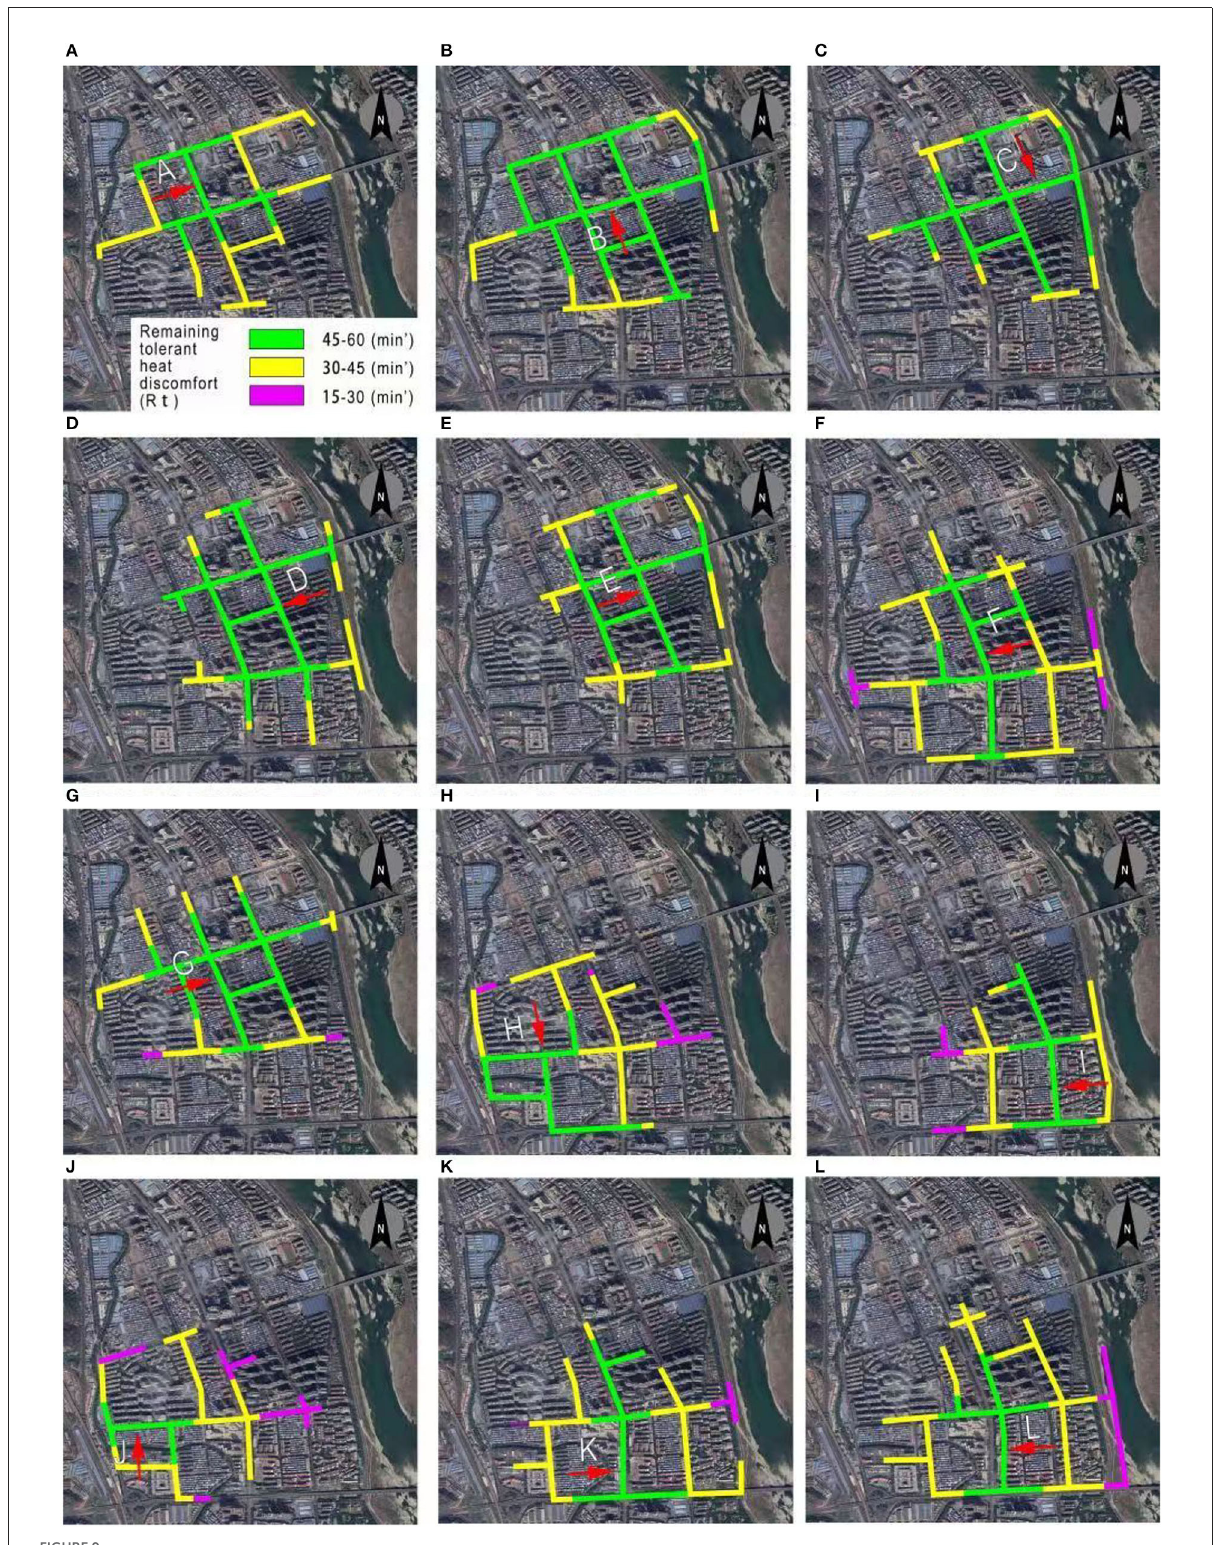
FIGURE9 Identification of remaining tolerant heat discomfort of all possible walkable routes of 12 neighborhoods. (A) Neighborhood-A, (B) Neighborhood-B, (C) Neighborhood-C, (D) Neighborhood-D, (E) Neighborhood-E, (F) Neighborhood-F, (G) Neighborhood-G, (H) Neighborhood-H, (I) Neighborhood-I, (J) Neighborhood-J, (K) Neighborhood-K, (L)